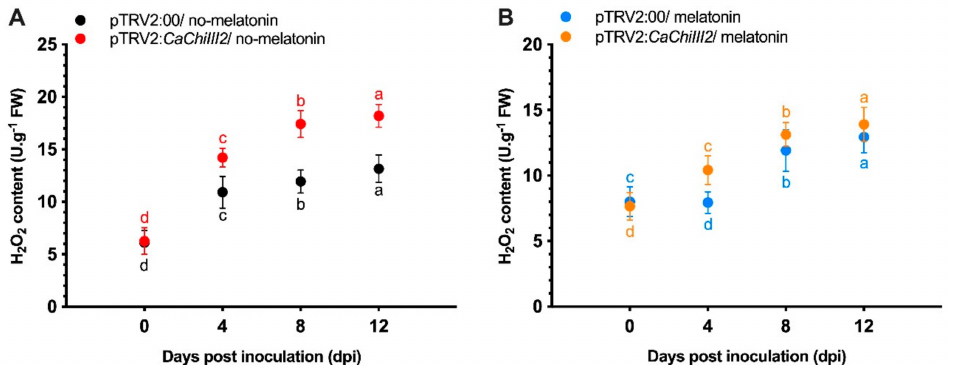
Figure 7. Effect of CaChiIII2 knockdown and exogenous melatonin application on H 2 O 2 content in pepper leaves inoculated with C. gloeosporioides . ( A ) Pepper leaves pretreated with a mock solution, ( B ) 100 µ M melatonin pretreated. Mean values ± SDs for five replicates are presented. Lower case letters (a–d) represent significant differences at p ≤ 0.05 using the DMR test.